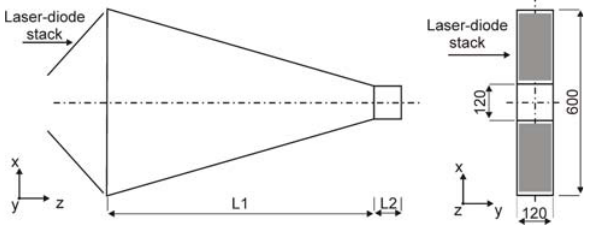
Fig. 5. Schematic layout of three-dimensional hollow-duct- system investigated